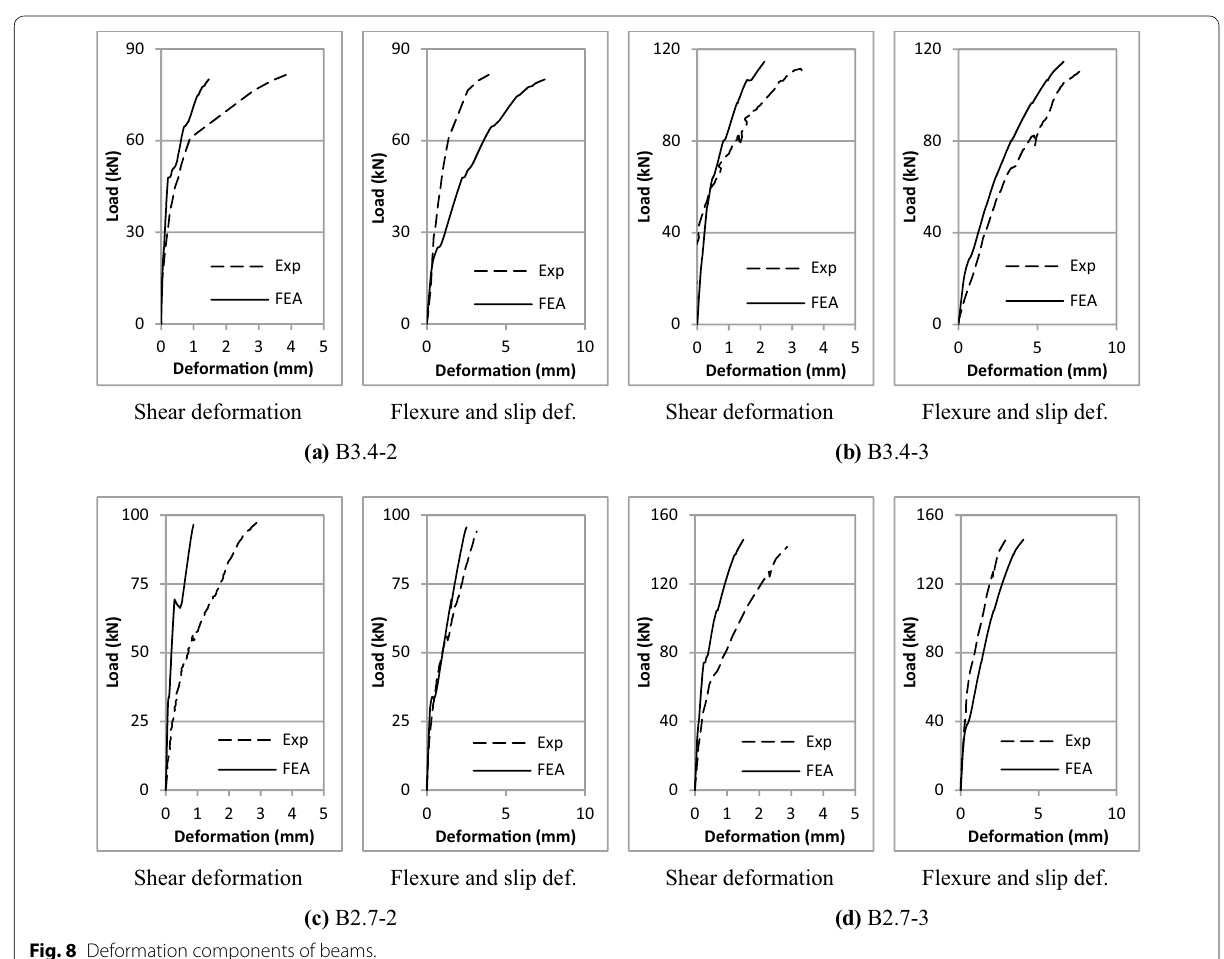
Fig. 8 Deformation components of